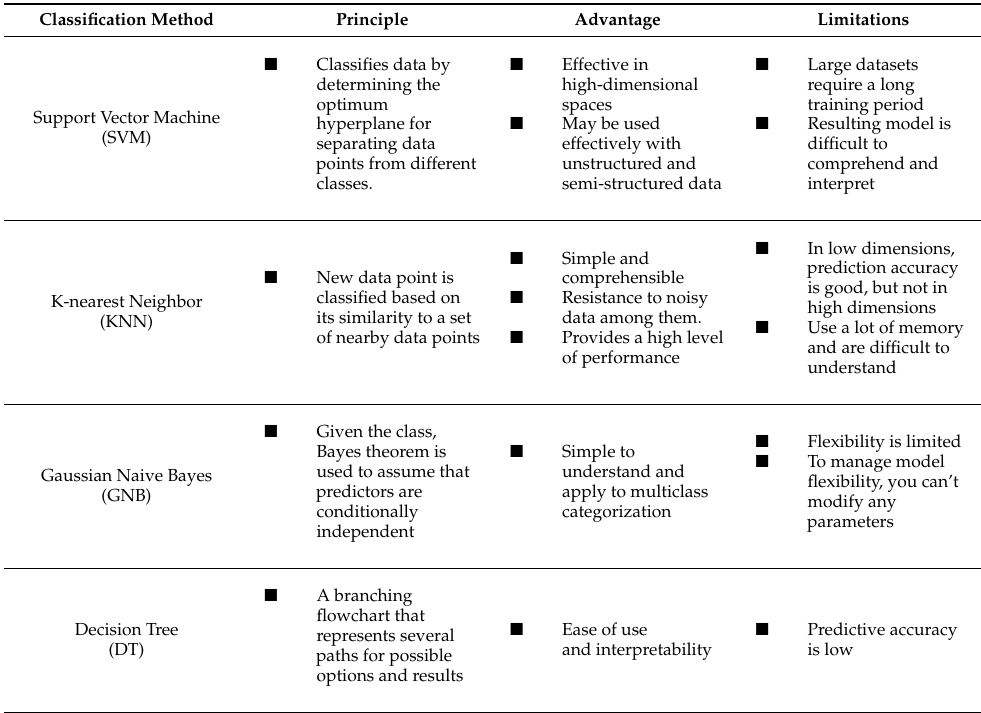
Table 3. List of the machine learning algorithms used in this